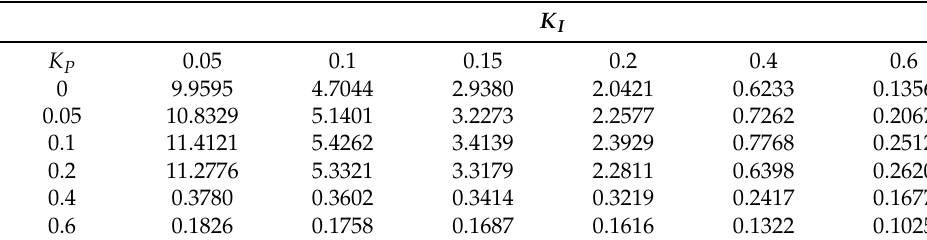
Table 5. Delay margin ( G m = 3, Φ m = 0 ◦ ).